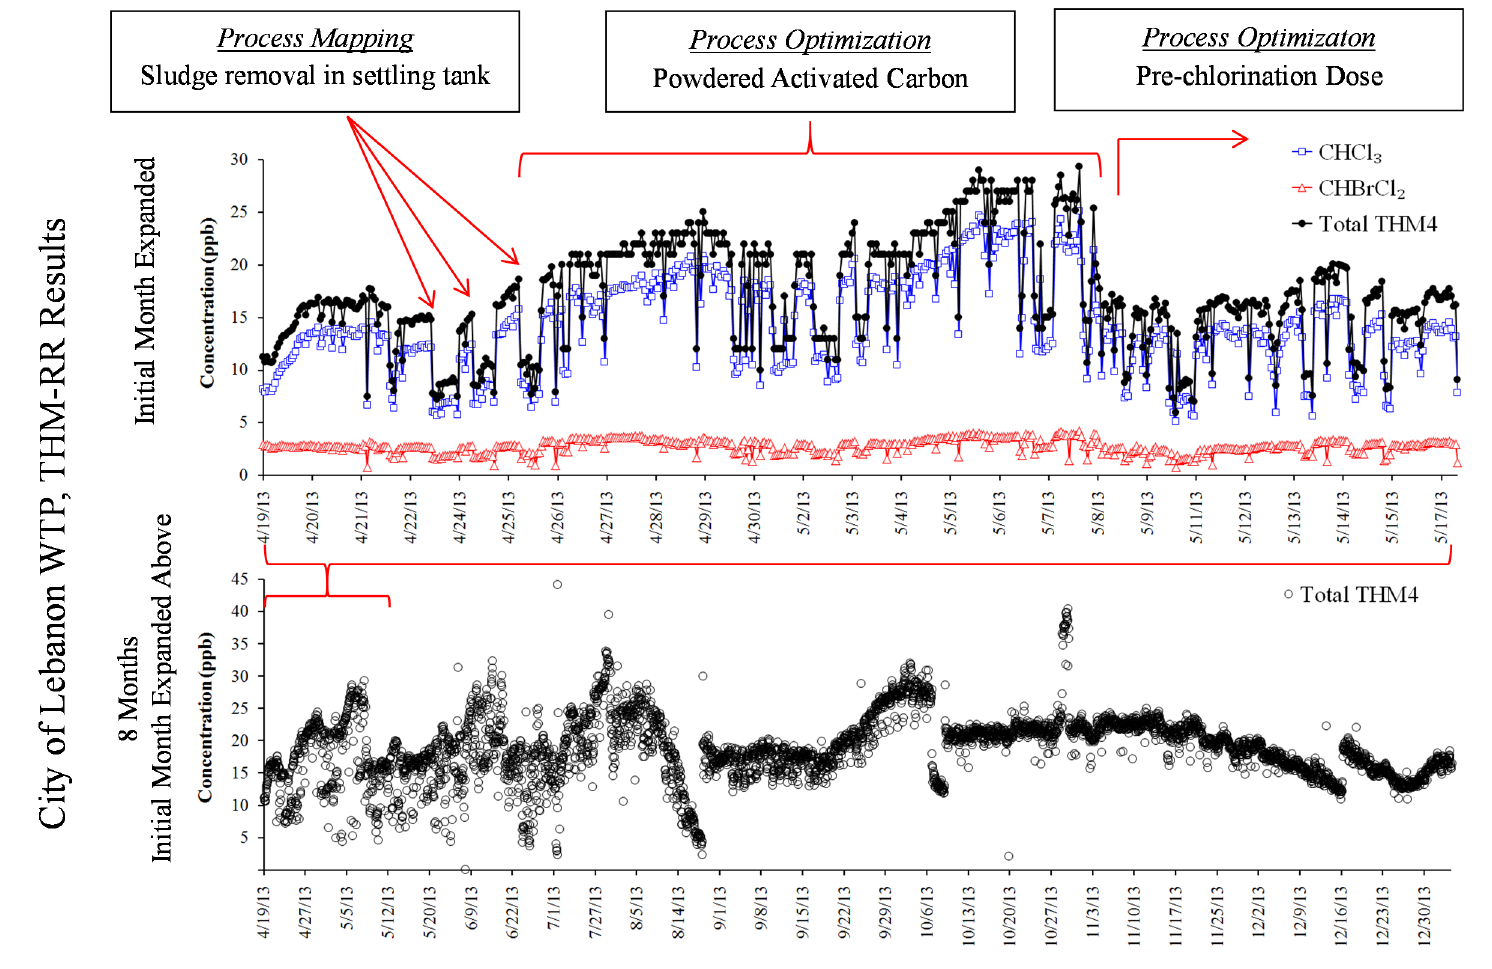
Figure 2. ( A ) Initial Month Expanded: Typical process map and two factor process optimization study conducted at the Lebanon, TN WTP for optimization of powdered activated carbon (PAC) dose and prechlorination dose; ( B ) The 8 month plot illustrates the large quantity of THMs concentration data obtained after establishing the on-line monitoring program at the Lebanon, TN WTP, and the consistent treatment practices implemented after 1 September 2013 to reduce THMs